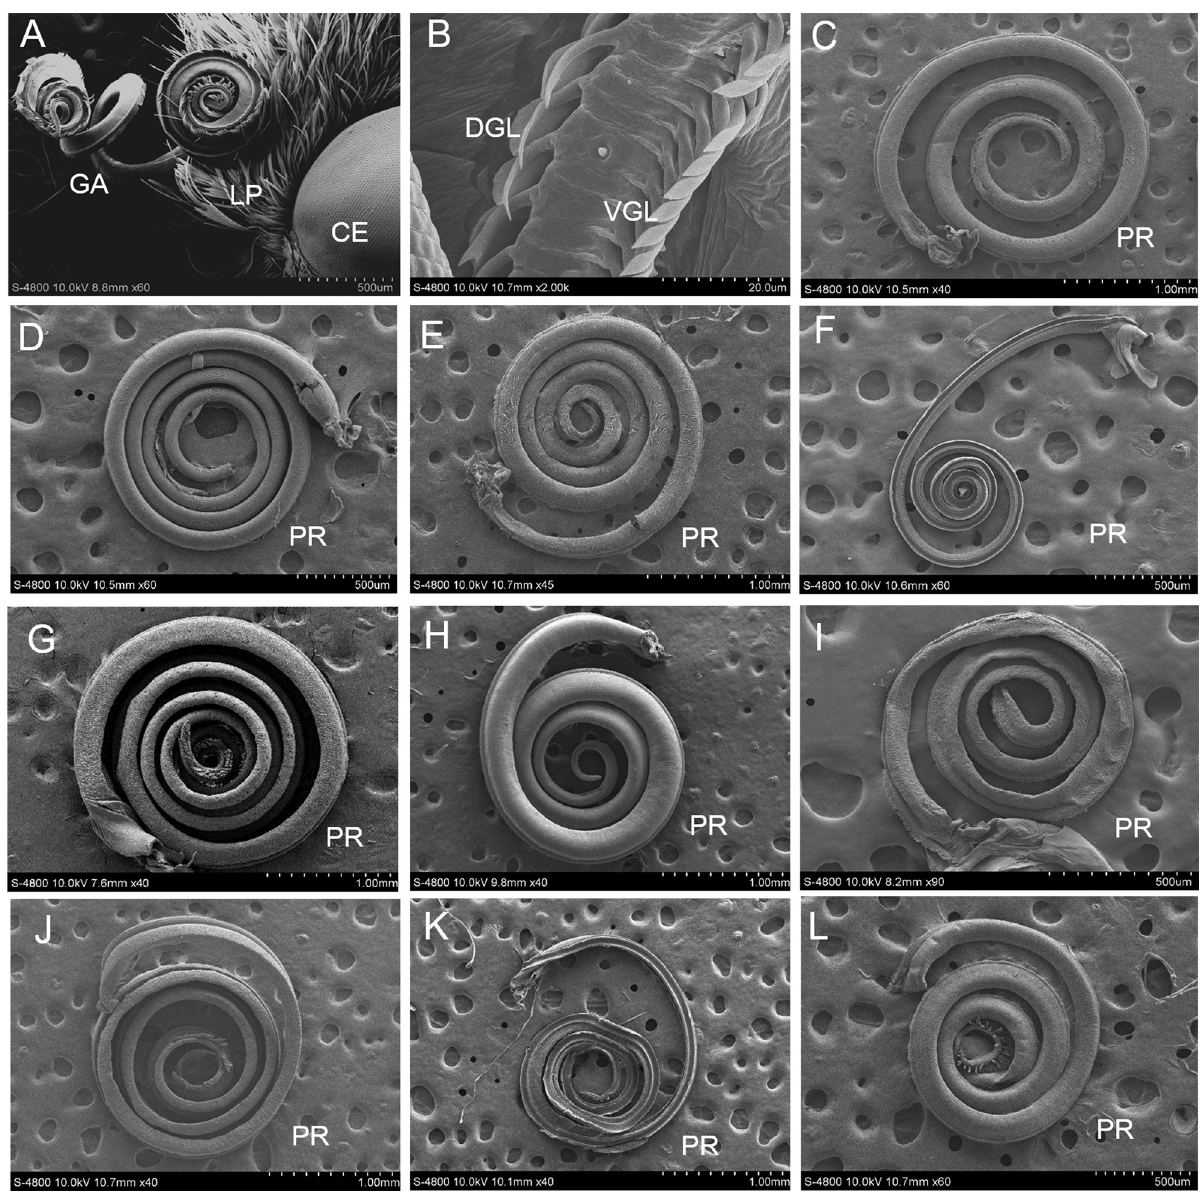
Fig 1. Morphology of proboscis. A: Proboscis (PR) coiled between the labial palpi (LP); CE: compound eye; GA: galea; LP: labial palpus. B: Inner view of the proboscis, showing the dorsal (DGL) and ventral galeal linkage (VGL). C-L: The proboscis. C: I . podalirius ; D: P . guttata ; E: Co . fieldii ; F: Ce . oreas ; G: Sa . charonda ; H: T . limniace ; I: A . issoria ; J: St . neumogeni ; K: Ca . suroia ; L: L . celtis .